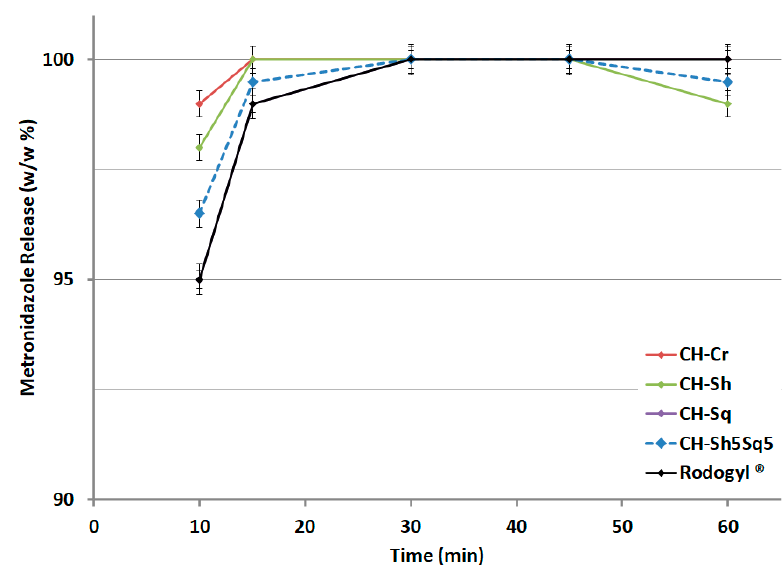
Figure 13. Dissolution profile of spiramycin (0.75 M UI) tablets comprising compacted CHs or CH mixture (CH-Sh5Sq5) compared to Rodogyl ® tablets. Table 8. Time for full drug release for metronidazole ® (125 mg) and spiramycin ® (0.75 M UI) tablets comprising compacted pure CHs from different sources, and CH mixture (CH-Sh5Sq5) compared to Rodogyl ® tablets.